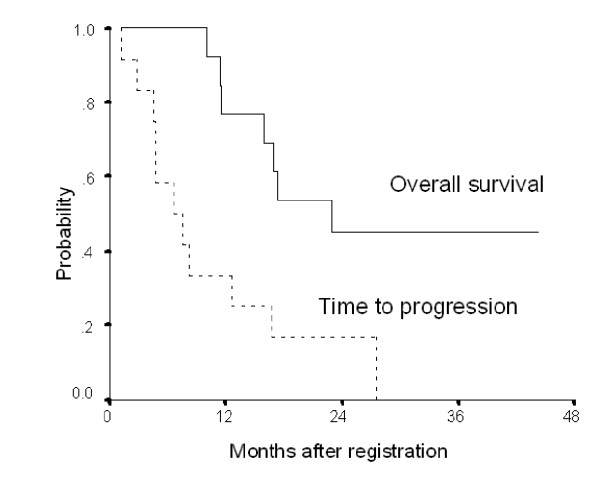
Estimated curves of overall survival and time to progression. At a median follow-up of 40.5 months (95% CI, 36.4–44.6 months), the median time to progression was 6.6 months (95% CI, 3.9–9.4 months) and the median overall survival was 22.9 months (95% CI, 17.2–28.5 months).